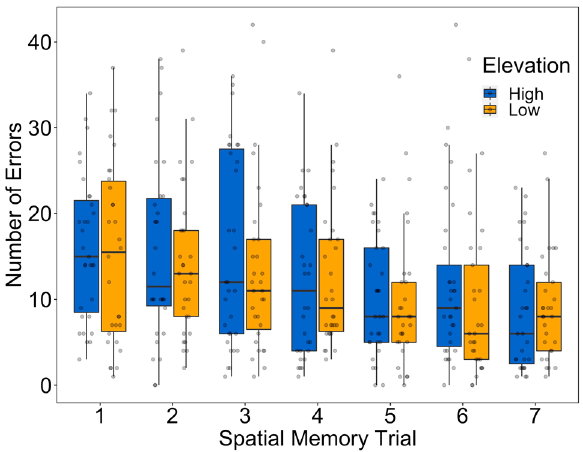
Figure 2. Boxplot of the untransformed number of spatial memory errors across spatial memory trials. High elevation birds are in blue, low elevation birds are in orange. Raw number of errors are plotted in grey.